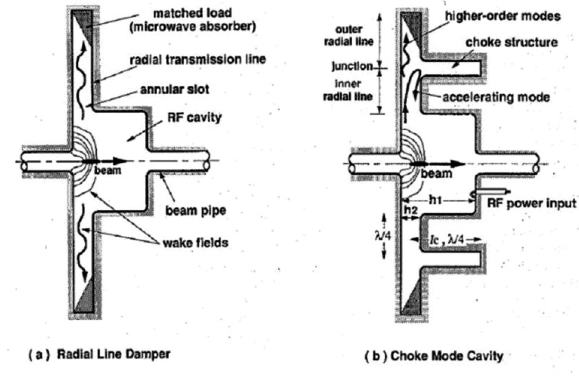
FIG. 1. The choke-mode